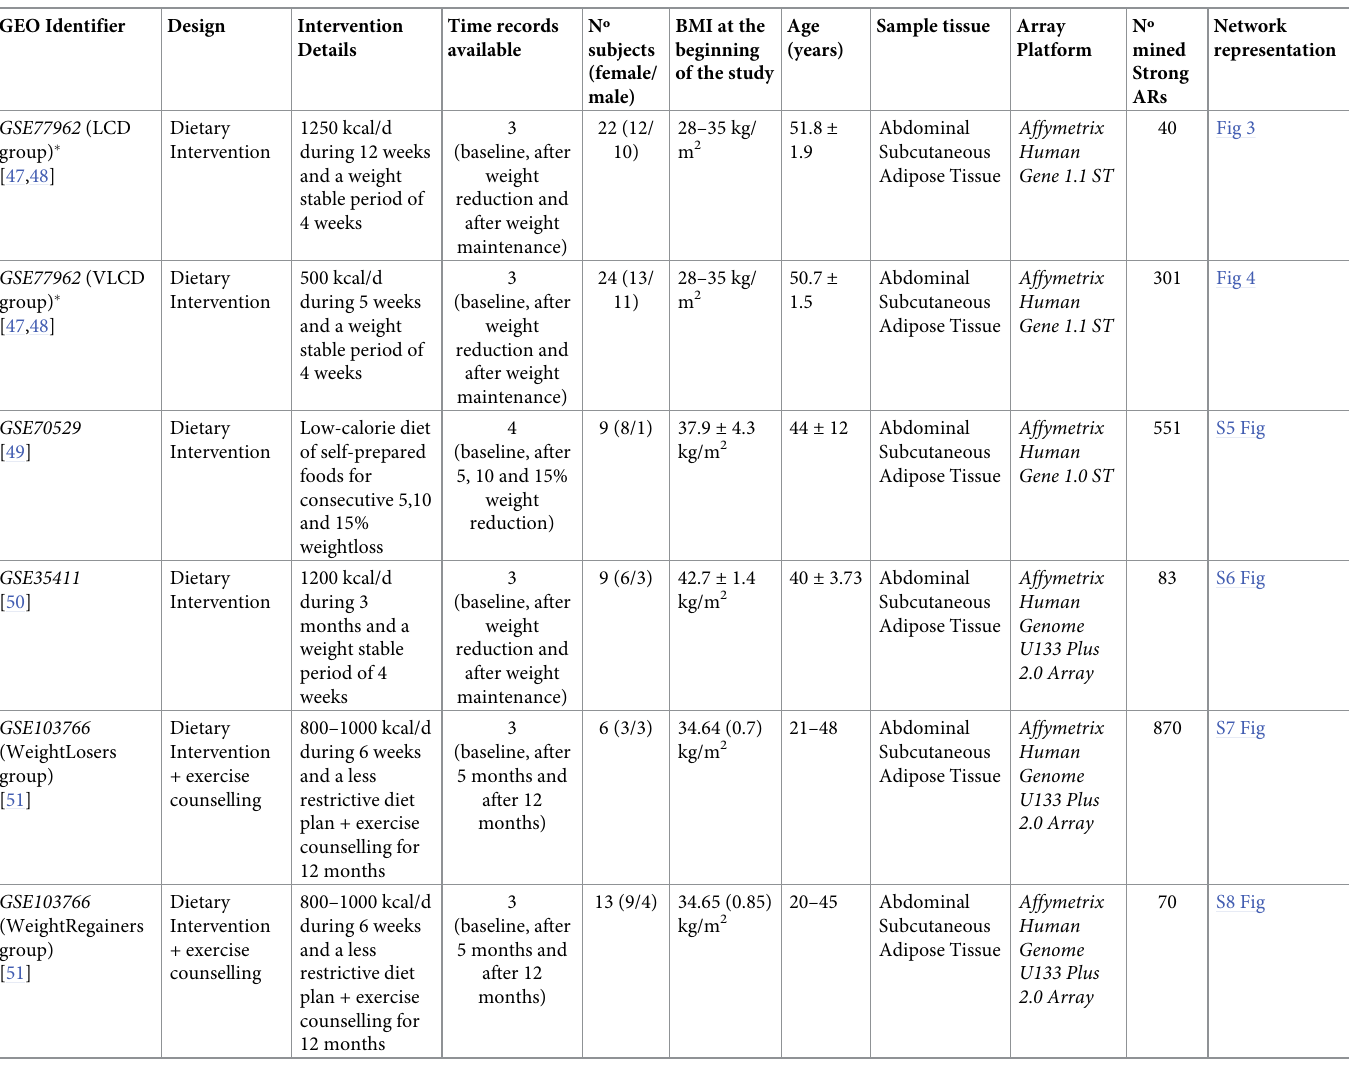
Table 1. Datasets details and problem description.